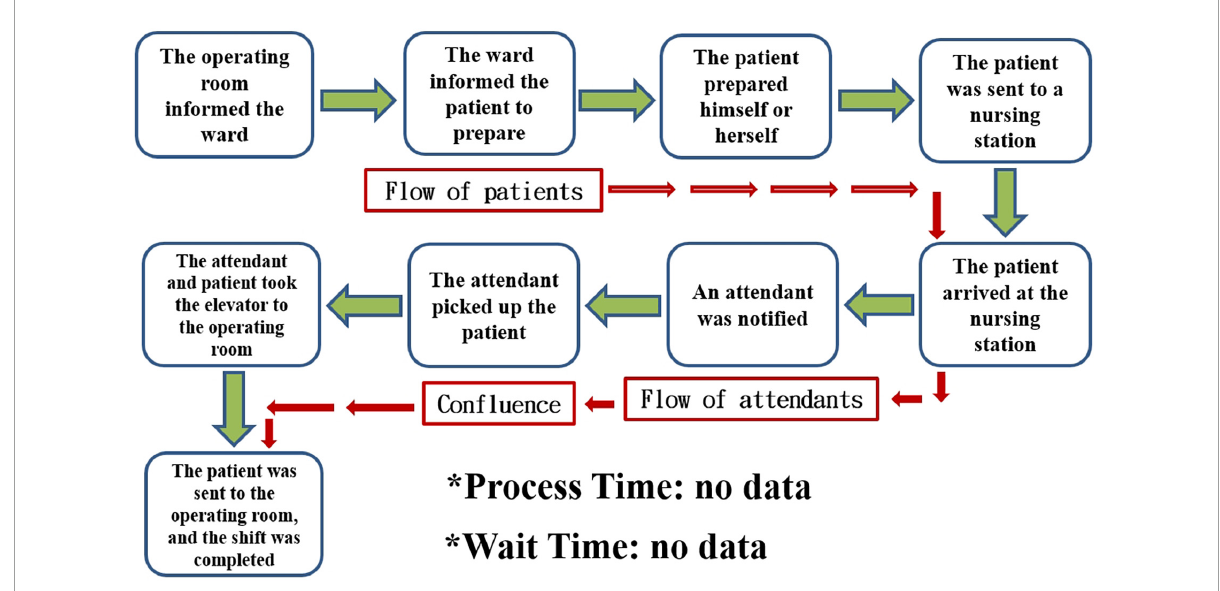
FIGURE1 The entire flow of inpatients who are sent to the operating room in the existing